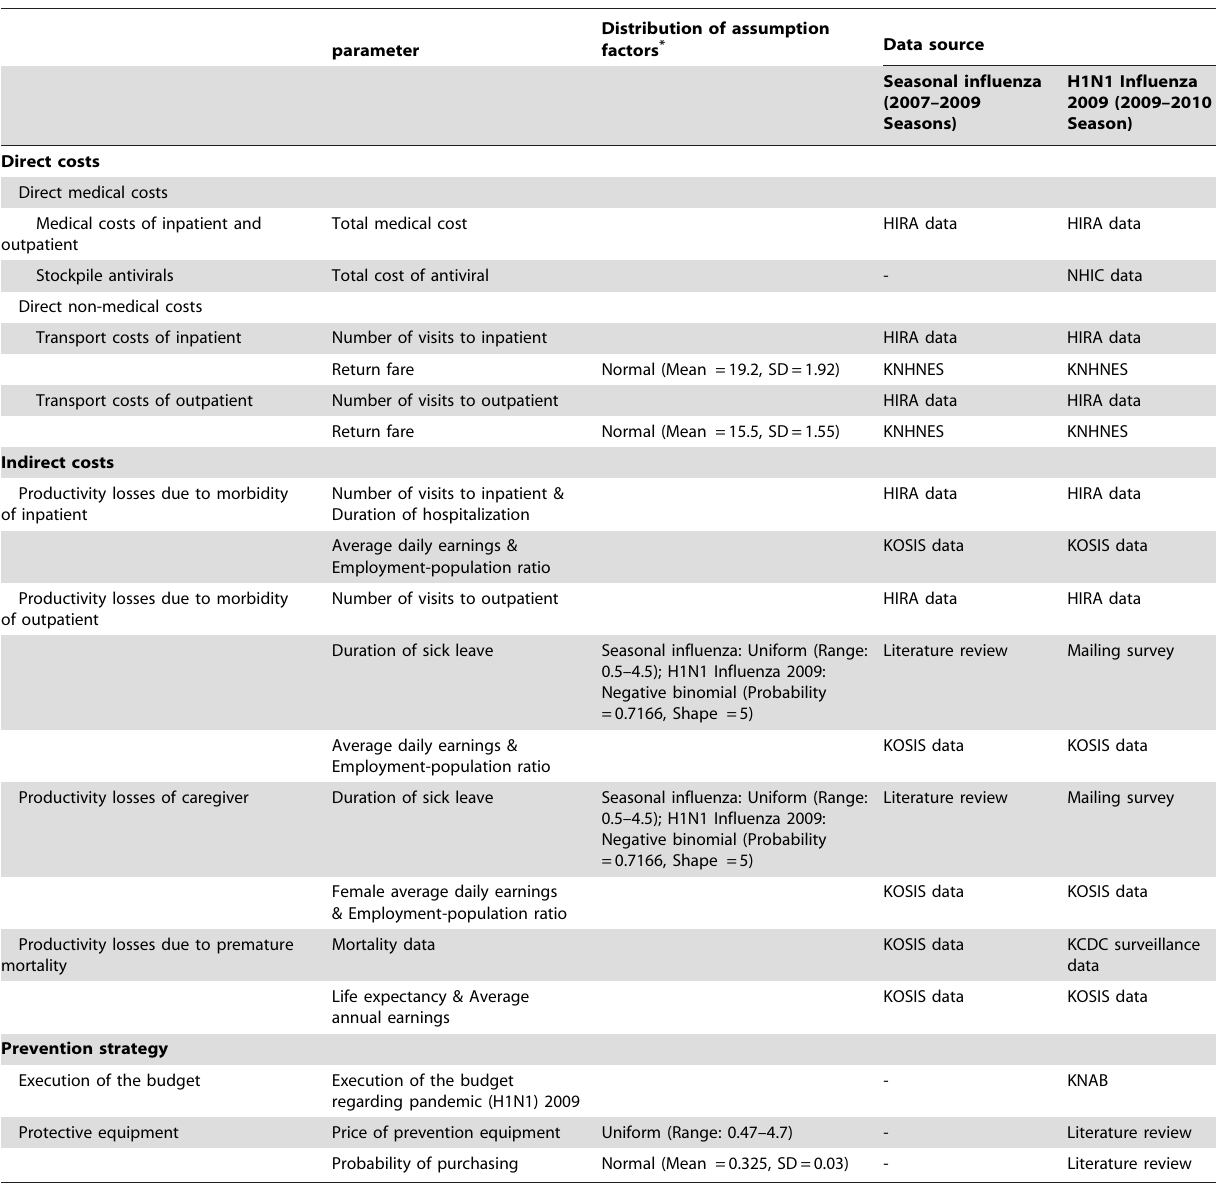
Table 1. Parameter and data